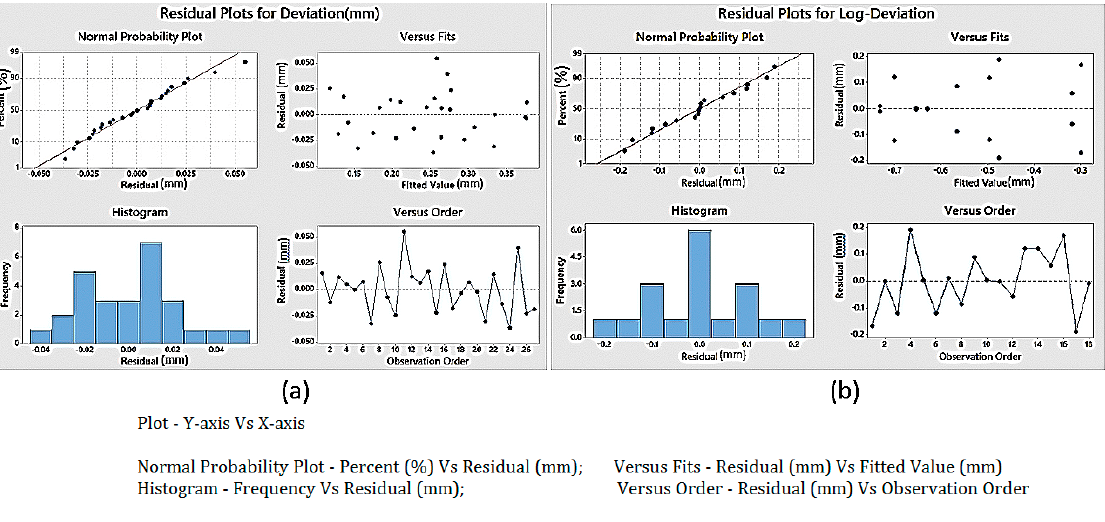
Figure 11. Normality test for accuracy ( a ) laser scanner; ( b ) white light scanner.